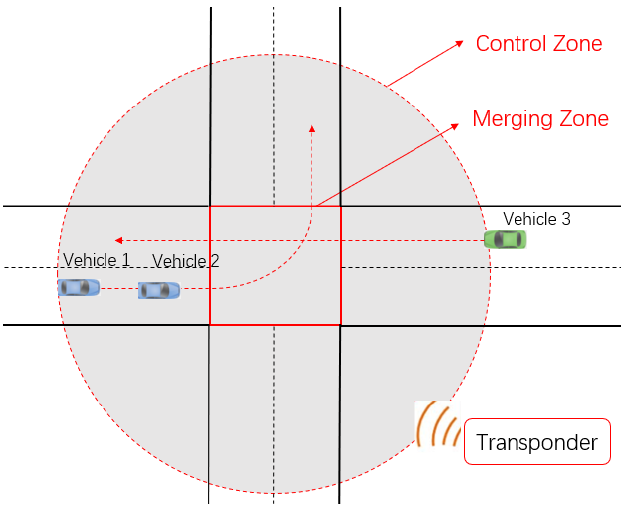
Figure 3. Illustration of two kinds of collisions in the isolated intersection.